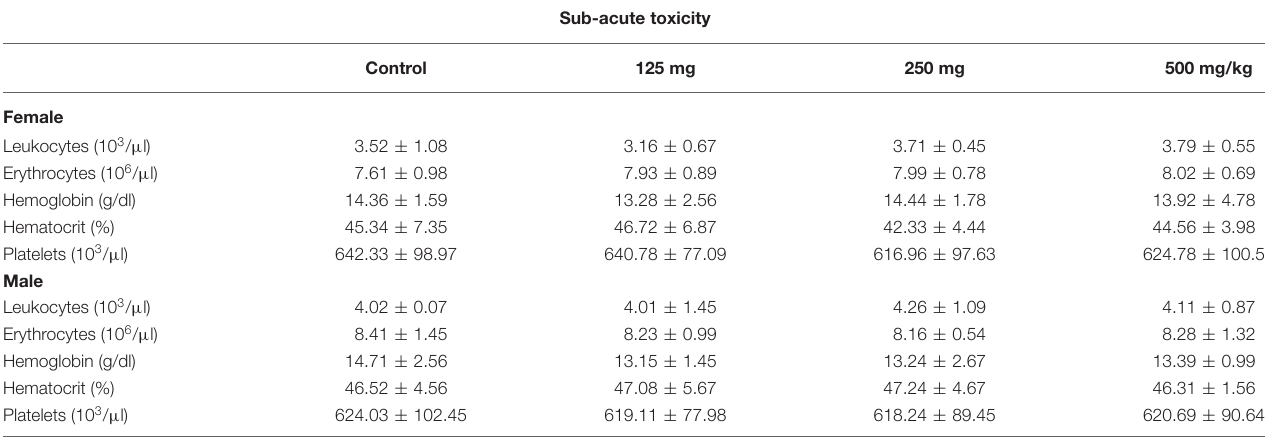
TABLE 2 | Hematological parameters of female and male Wistar rats treated orally with fungal taxol in the sub-acute toxicity